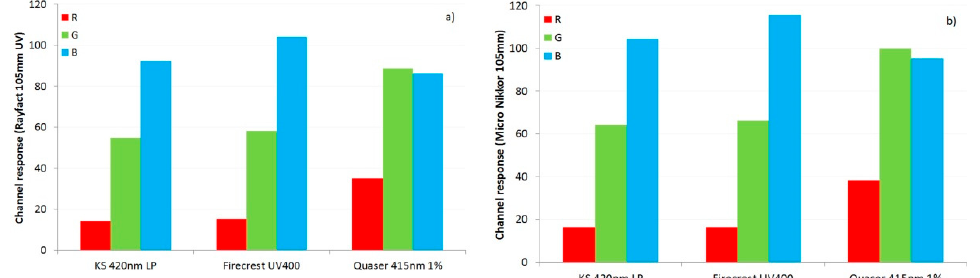
Figure 5. Red, green and blue channel response from an area of the black background in the RAW images for the three UV blocking filters for ( a ) the Rayfact 105 mm UV lens and ( b ) Micro Nikkor 105 mm lens.